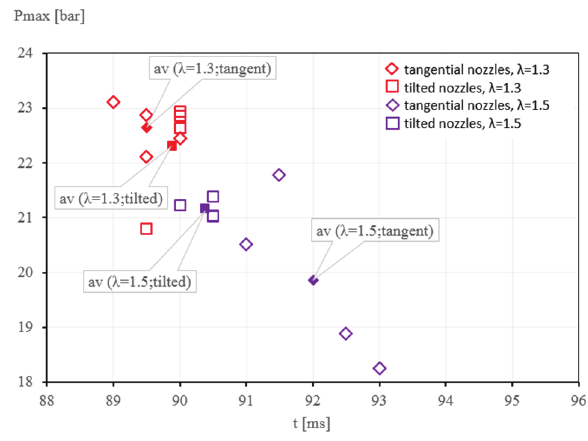
Fig. 6. Pmax for tangential and tilted nozzles The Pmax values over their occurrence time at λ = 1.3 and λ = 1.5 (red and violet color respectively) for tangential (rotated squares) and tilted (squares) nozzles have Fig. 5. Cylinder pressure (a) and HRR (b) for SI (solid line) and TJI (dashed line)